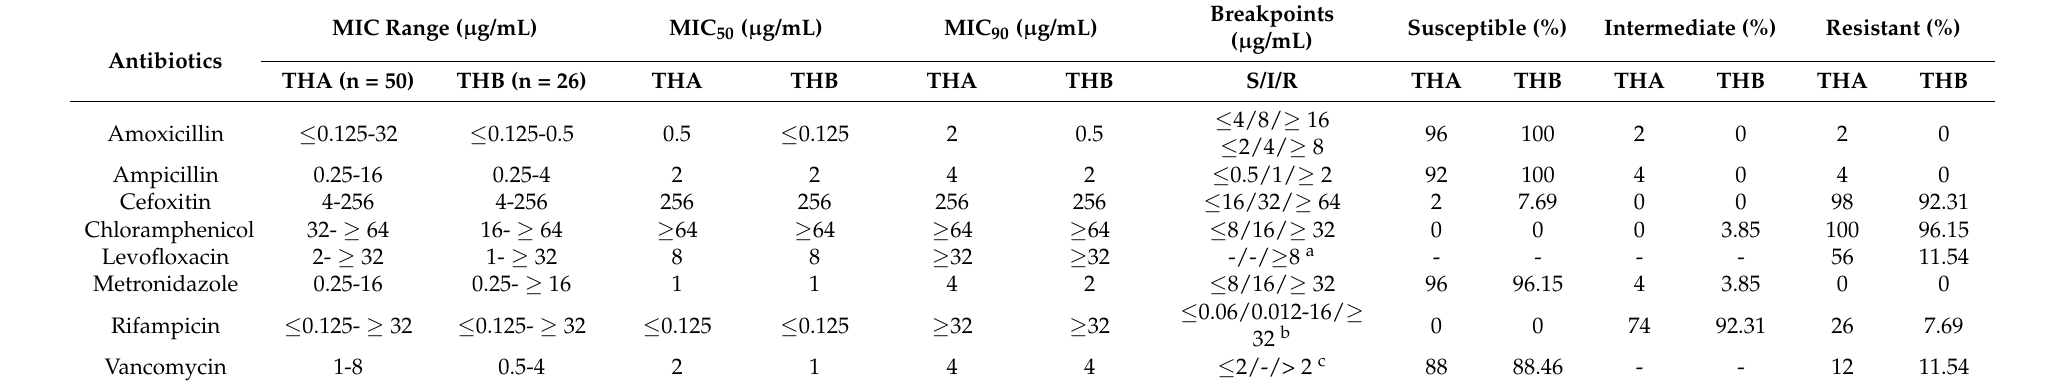
Table 2. Antibiotic susceptibility patterns of C. difficile isolates in Thailand.